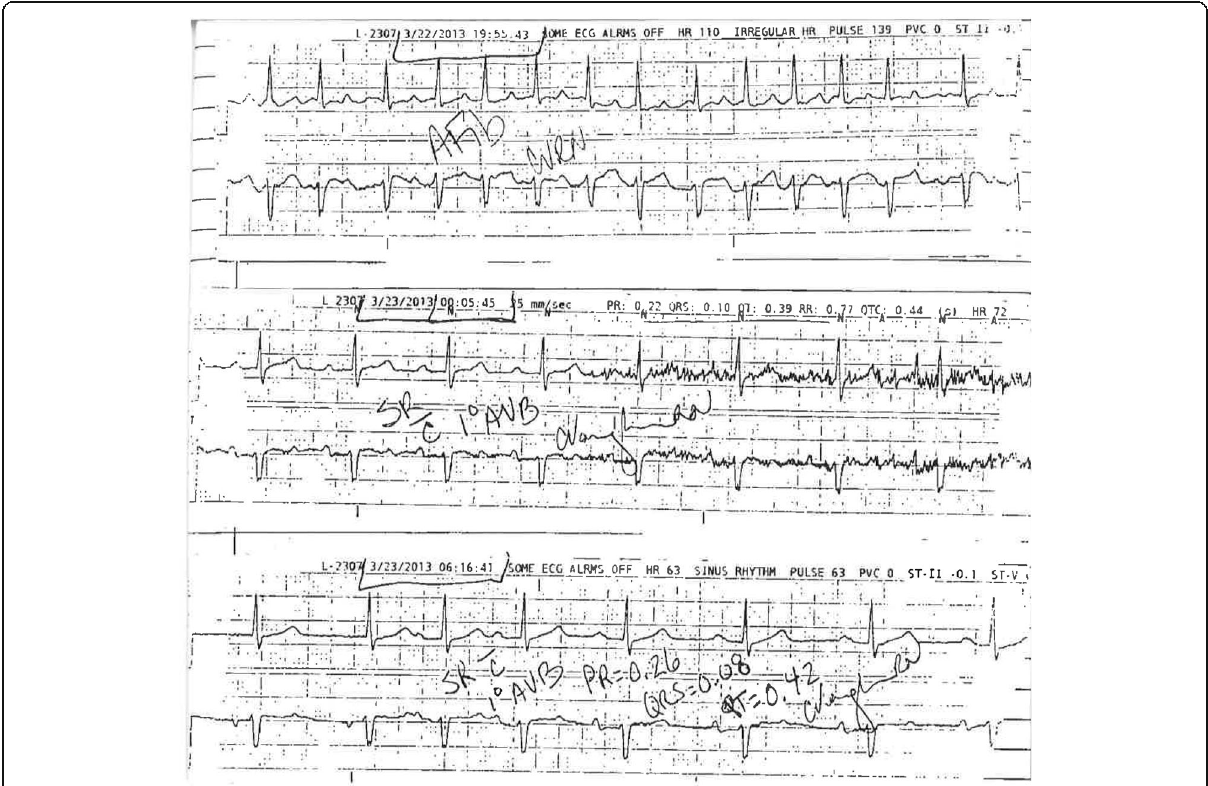
Fig. 2 Rhythm strips showing conversion from atrial fibrillation to normal sinus